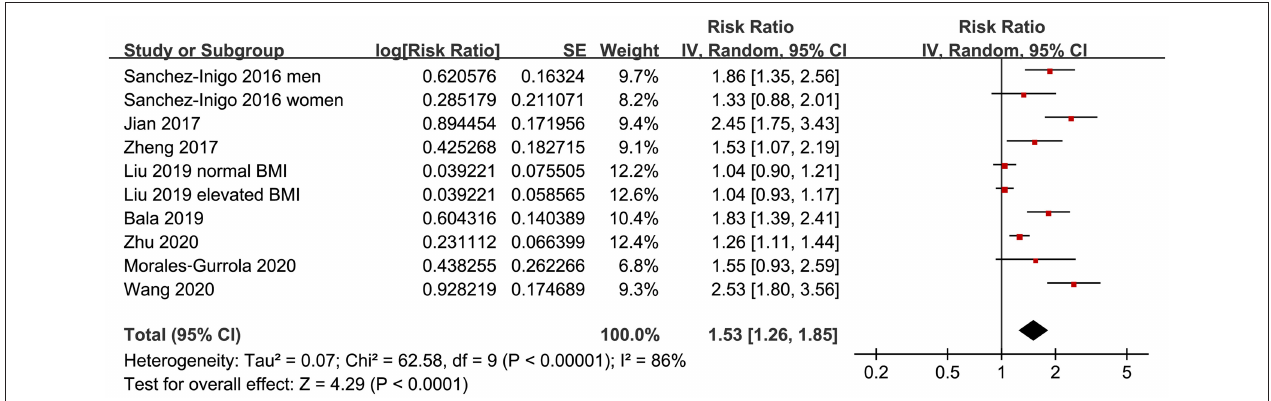
FIGURE 2 | Forest plots for the meta-analysis of the association between triglyceride-glucose (TyG) index and hypertension in community-derived adult population.